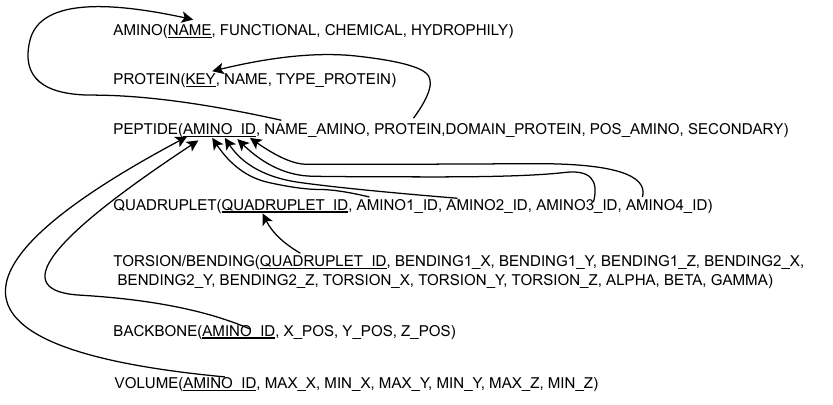
Figure 4. Conceptual scheme translation in logical